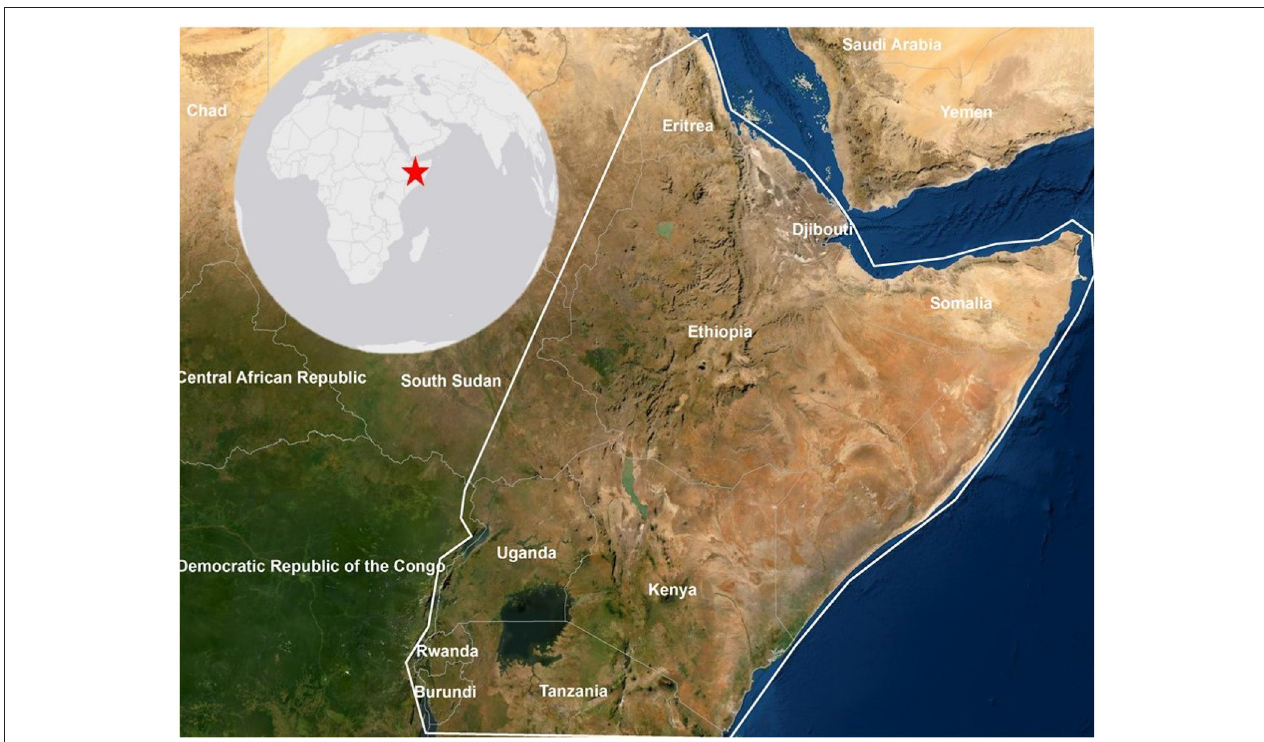
FIGURE 2 | The study area includes Burundi, Djibouti, Eritrea, Ethiopia, Kenya, Rwanda, Somalia, parts of Sudan and South Sudan, Uganda, and